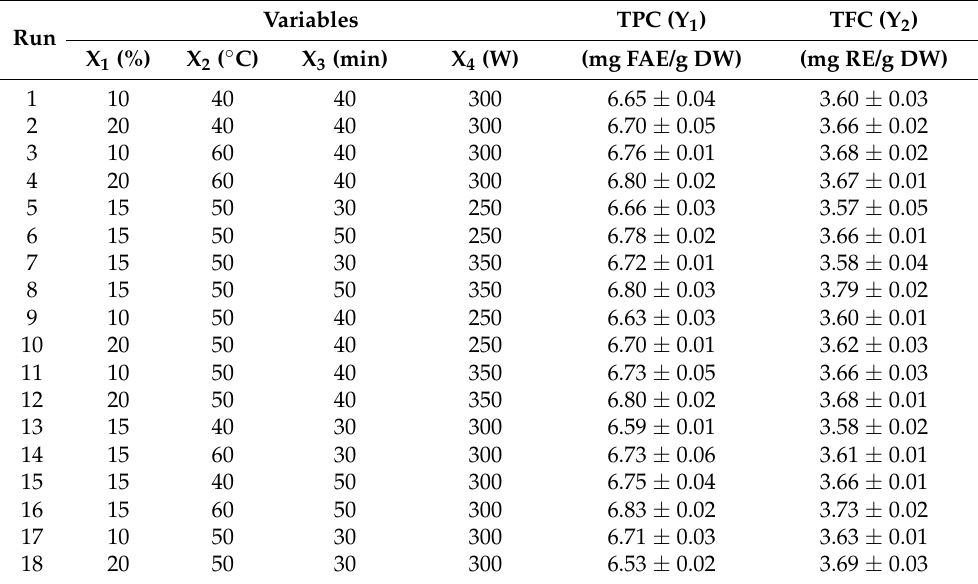
Table 2. Experimental design and results of response surface